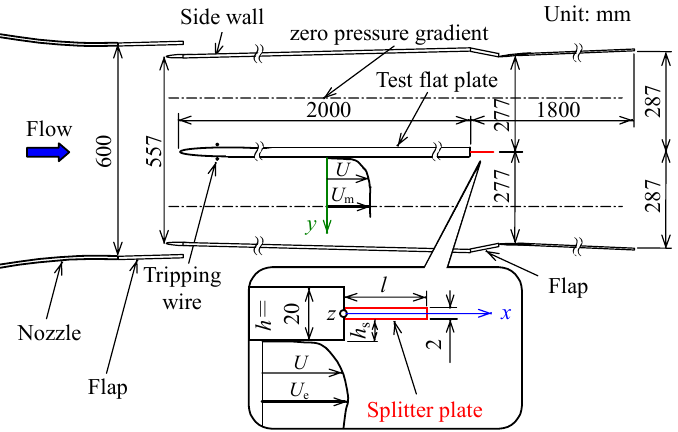
Fig. 1 Configuration of flow field and coordinate